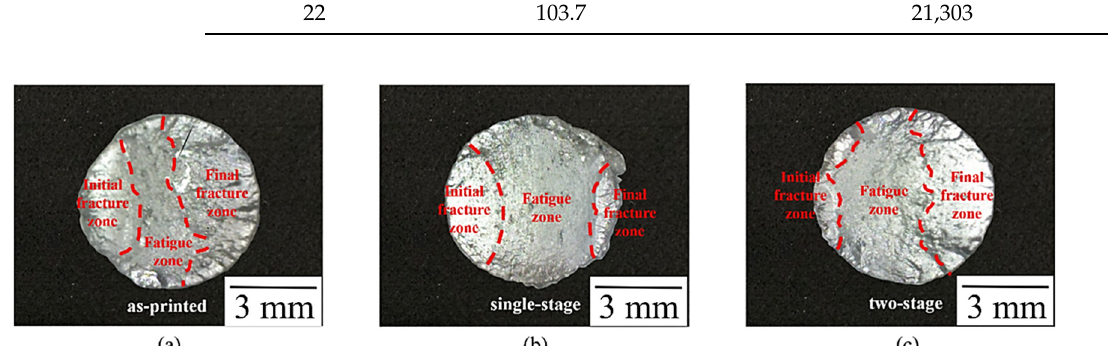
Figure 8. S–N curve of the SLM Al–Mg–Sc–Zr alloys.